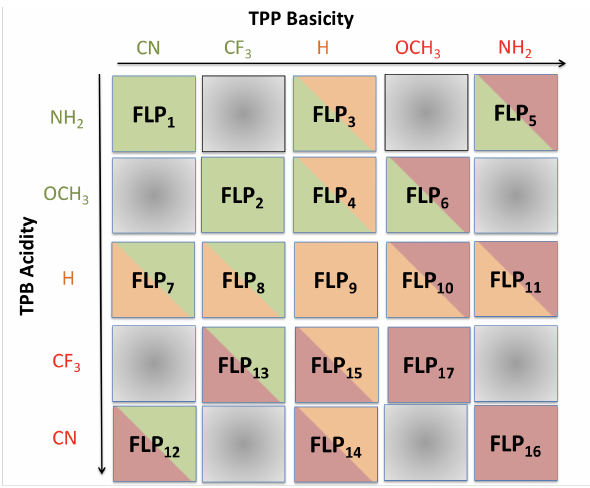
Figure 3. Combinations of the TPB- and TPP-derivatives to generate the 17 FLPs. Green, orange and red colors state for weak, moderate and strong acids and